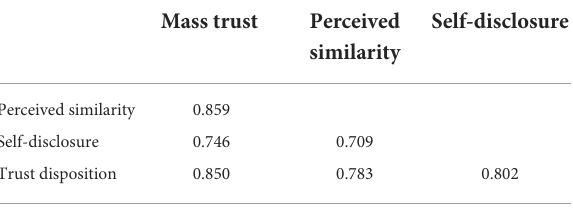
TABLE 4 Results of discriminant validity by HTMT.